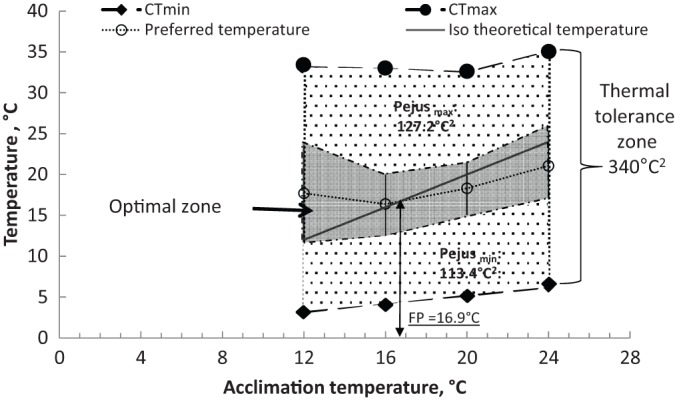
Preferred temperatures, CTmin and CTmax, and thermal window for Hemigrapsus crenulatus acclimated at different temperatures. Iso-theoretical temperature indicates when the temperature selected by crabs and the acclimation temperature are similar. With this line and preferred temperatures it is possible to calculate final preferendum (arrow). Area for maximum and minimum thermal Pejus (Pejusmax and Pejusmin, respectively) were calculated considering that CT indicates the critical threshold where aerobic scope is close to zero (Sokolova et al., 2012). The optimal zone was identified with the preferred temperatures. Values are mean±s.d.; n=13, 16, 12 and 12 for crabs acclimated at 12, 16, 20 and 24°C, respectively; n=9 for CTmax and n=9 for CTmin for crabs acclimated at each experimental temperature.